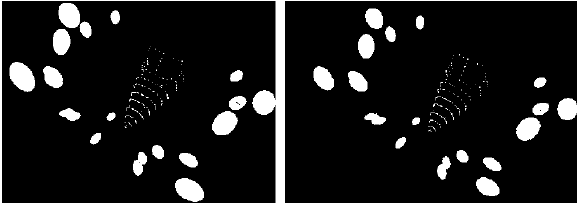
Figure 6. Camera station error ellipsoids for plane nose in scale of 1000 before (left) and after (right) omission of improper